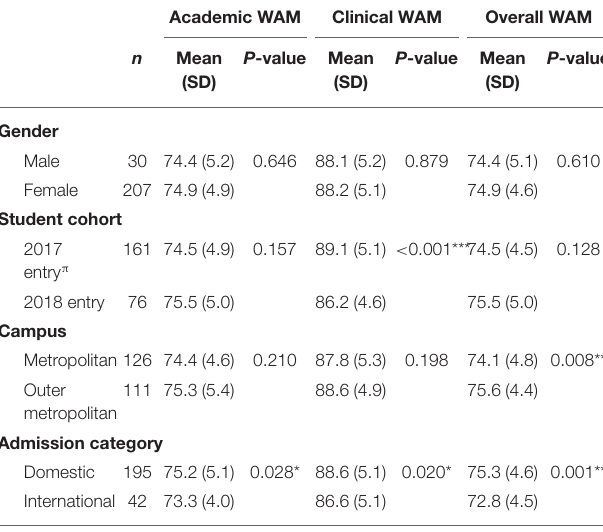
TABLE 3 | Univariate association of academic, clinical and overall performances WAM score using simple linear